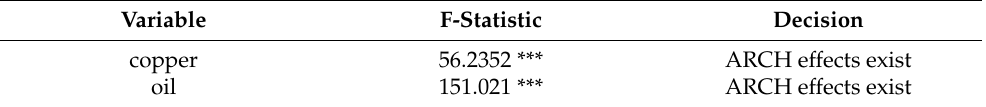
Table 6. ARCH/GARCH tests.